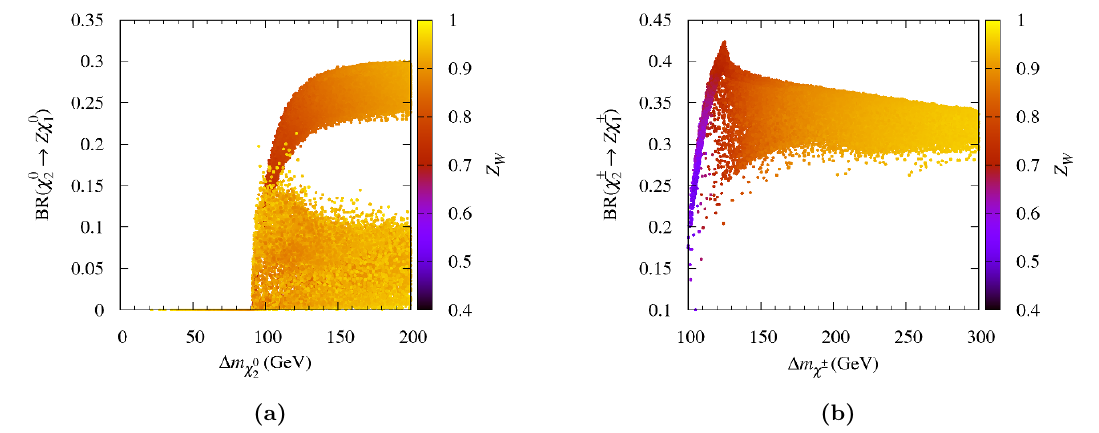
(cid:31) (cid:6) ! (cid:31) (cid:6) Z ) e e 2 1